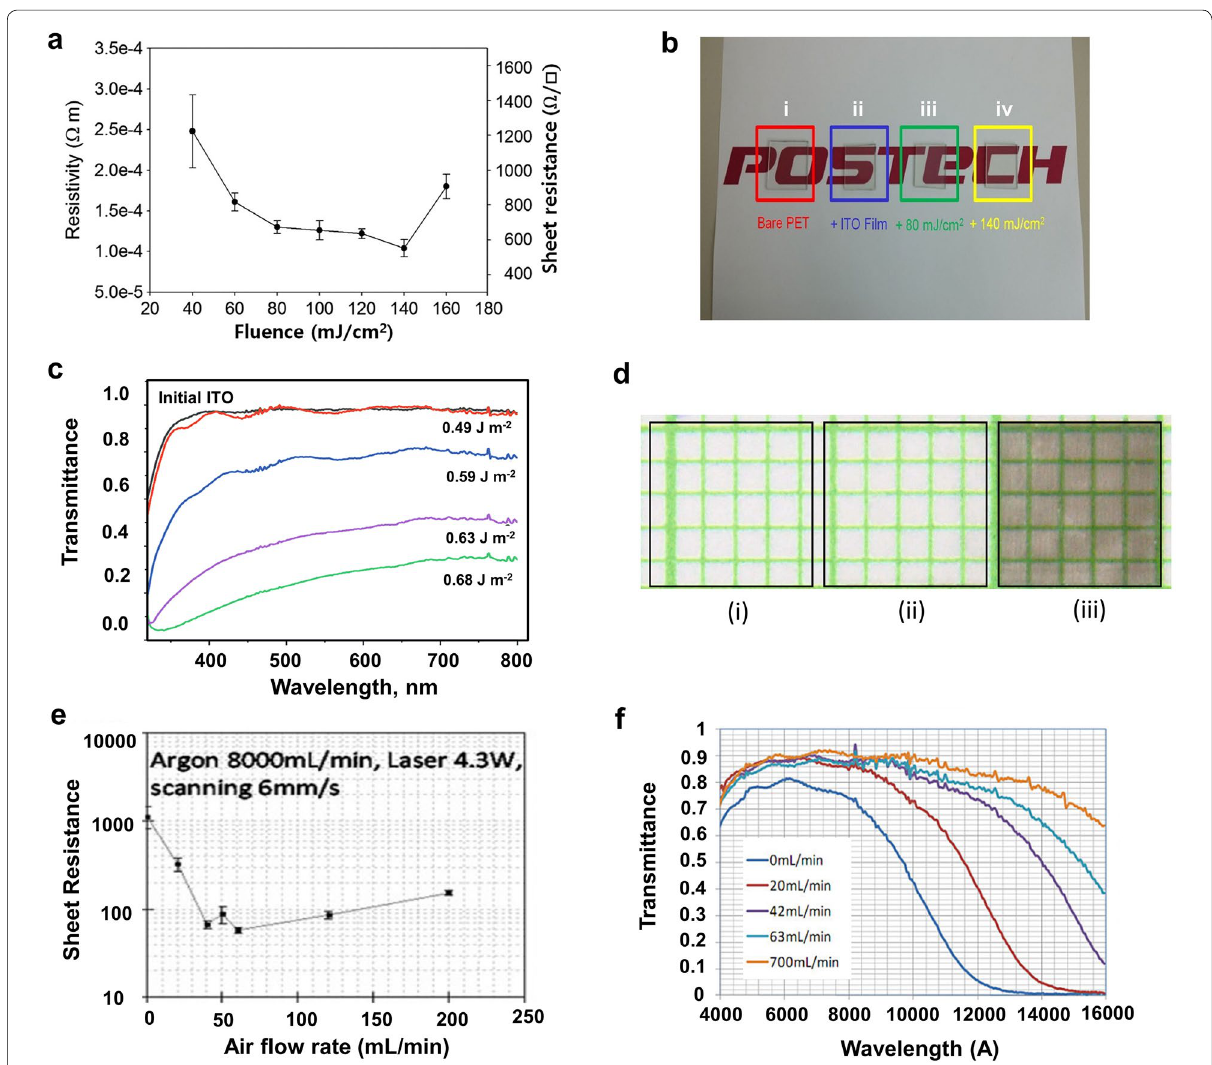
Fig. 2 a Variation of the electrical resistivity (sheet resistance) of the laser-irradiated ITO film depending on the laser fluence of a single pulse. b Optical image to compare the transparency of thin films after the laser process (i: bare PET; ii: ITO film only; iii: ITO film after a single laser pulse at 80 mJ cm − 2 ; iv: ITO film after a single laser pulse at 140 mJ cm − 2 ) ( a and b reproduced with the permission from Ref. [30]. Copyright Elsevier,